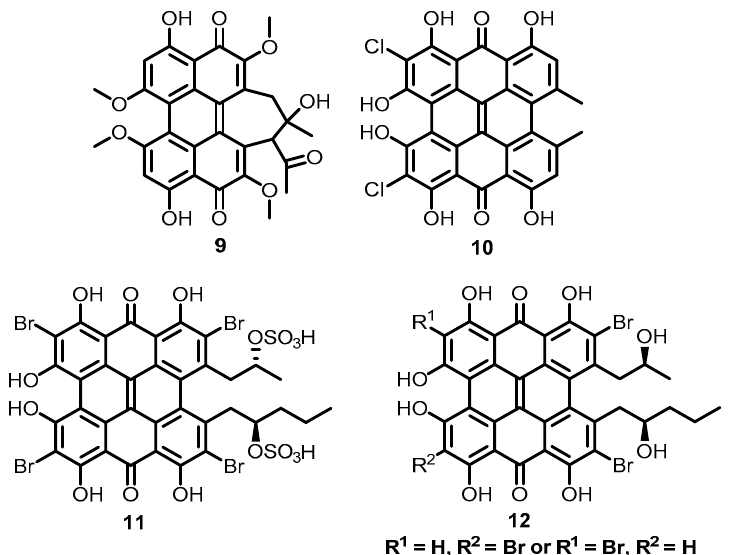
Figure 3. Other antiviral perylene quinone natural products.